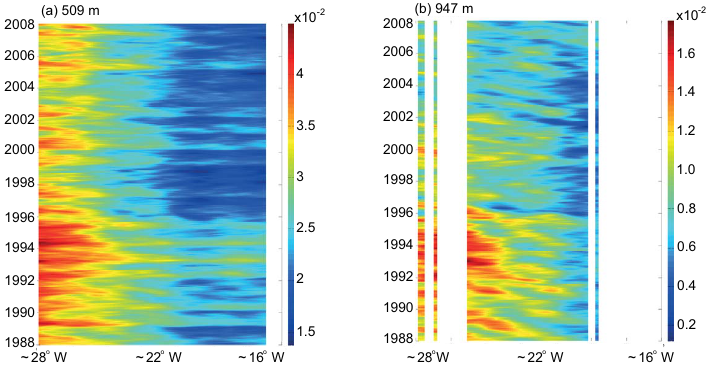
Figure 6. The northward trend of density (10 − 2 kgm − 3 ◦− 1 , regressed in the latitude range 45–62 ◦ N) in the northeast Atlantic (in the approximate longitude range 16–28 ◦ W), 5-day averages for 1988–2007: (a) at 509m; (b) at 947m.